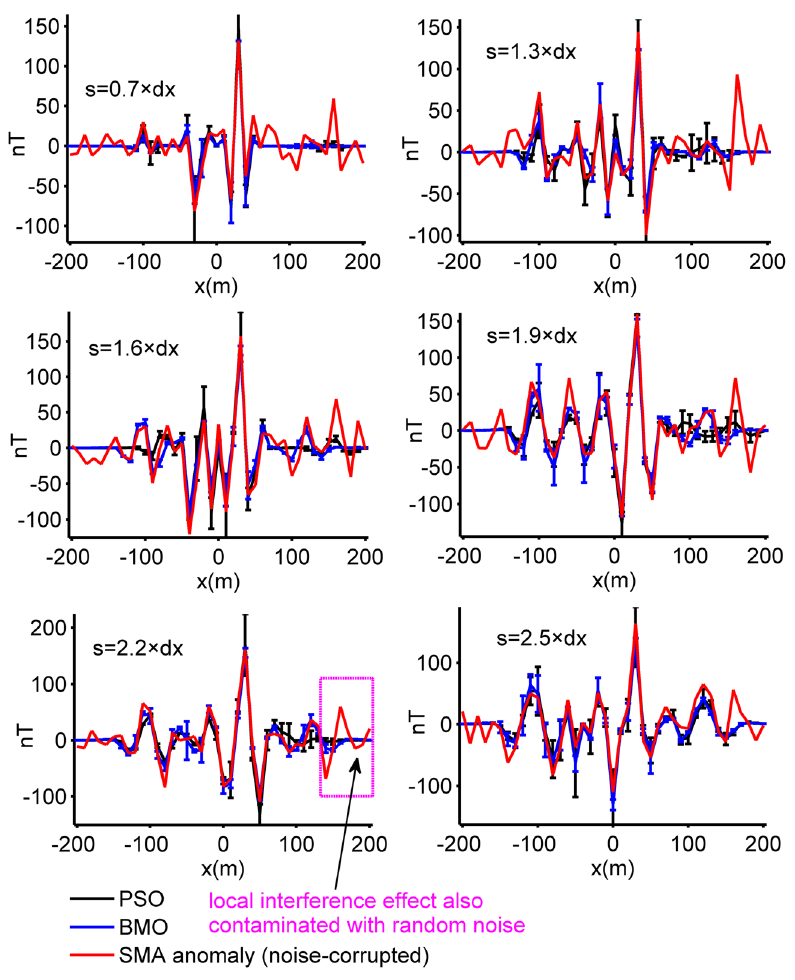
Figure 11. The SMA results of 40% random noise-corrupted magnetic anomalies of case 2 and estimated SMA magnetic responses via BMO and sPSO for different s values (0.7, 1.3, 1.6, 1.9, 2.2, and 2.5 × dx, dx = 10